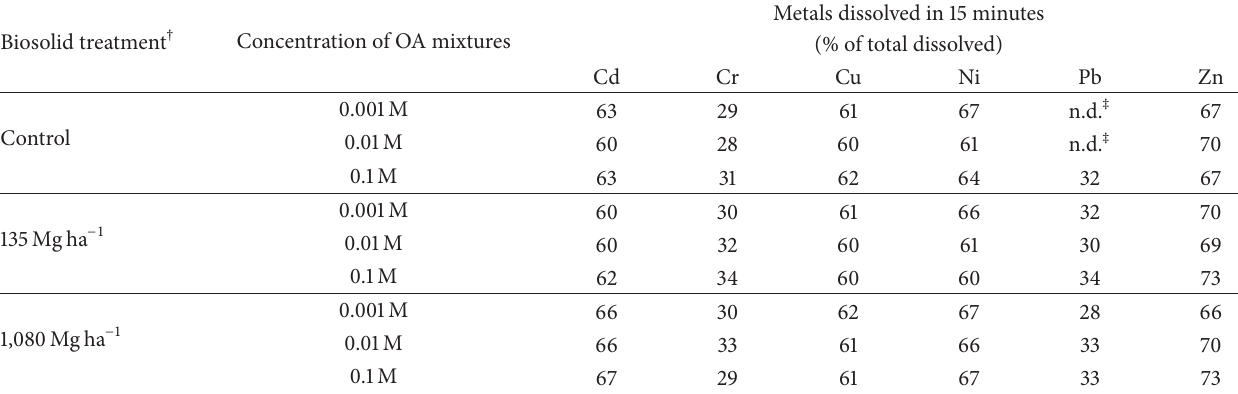
† Obtained at Moreno Field Station of the University of California, Riverside, CA. From 1976 through 1981, composted biosolids were applied at dry weight rates of 0 (control), 22.5, and 180Mgha −1 yr −1 , respectively. ‡ Concentration was below detection limits of the AAS for Pb = 0.001mgkg −1 . Table 10: Kinetics constant for metal dissolution reaction extracted by organic acid (OA) mixtures according to (1) and (2) † . Zero- and first-order kinetics constant Biosolid treatment ‡ Metal extracted by OAs (Mgha −1 ) 0.001 M Control